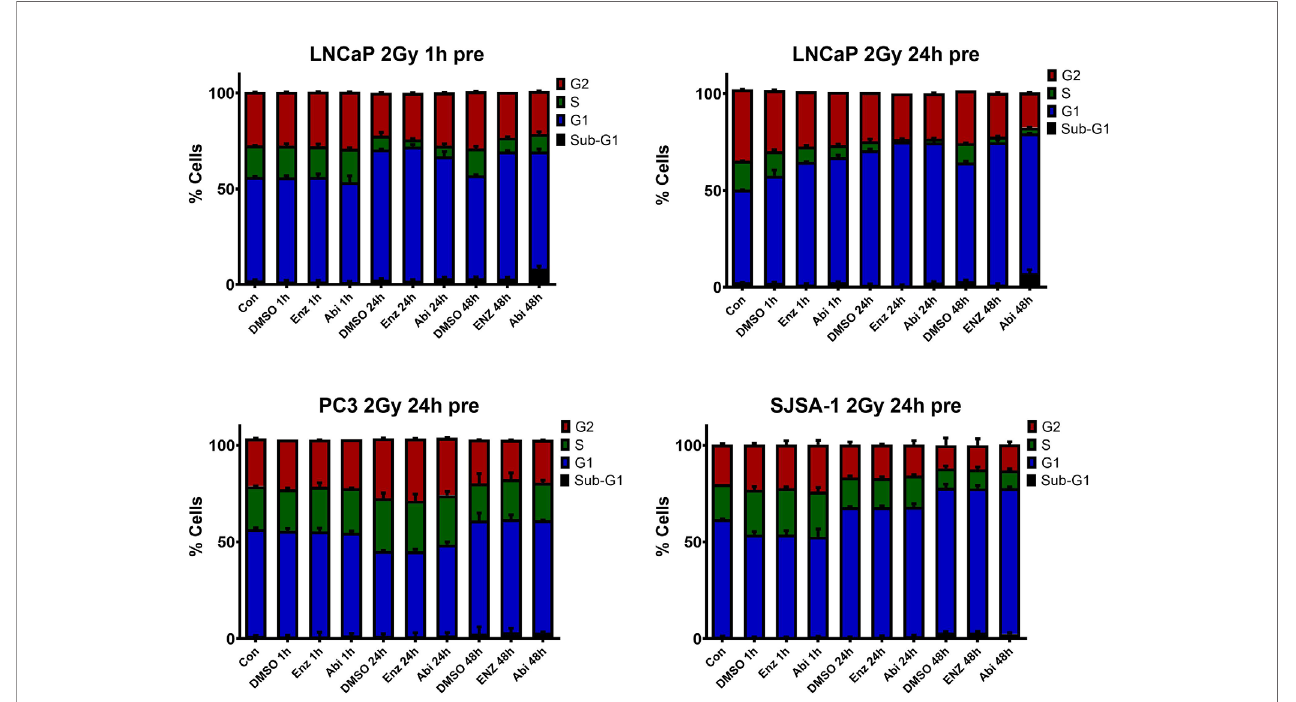
FIGURE 13 | Cell-cycle analysis of AR-sensitive LNCaP prostate model, AR- insensitive PC3 prostate model and osteoblastic bone model SJSA-1. Cells were treated with 10 m M Abiraterone, Enzalutamide or DMSO 1 or 24 hours before radiation with 2 Gy. Post radiation cells were fi xed in ice cold ethanol 1h, 24h and stained with PI/RNaseA for 30 minutes before the cell-cycle pro fi le was determined by fl ow cytometry. Error bars are standard error of the mean (SEM) (n=3).